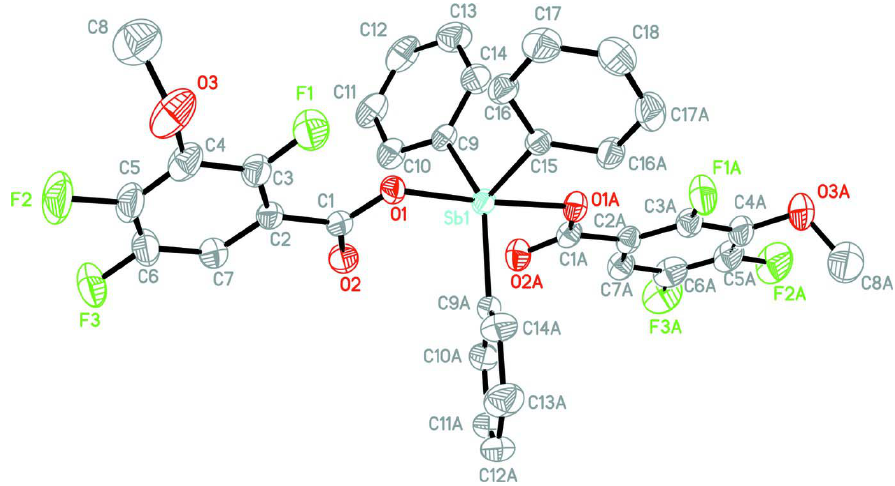
Figure 1 The molecular structure of the compound, showing 50% probability displacement ellipsoids. H atoms have been omitted for clarity. Symmetry code: (A) = 1 - x , y , 3/2 - z .